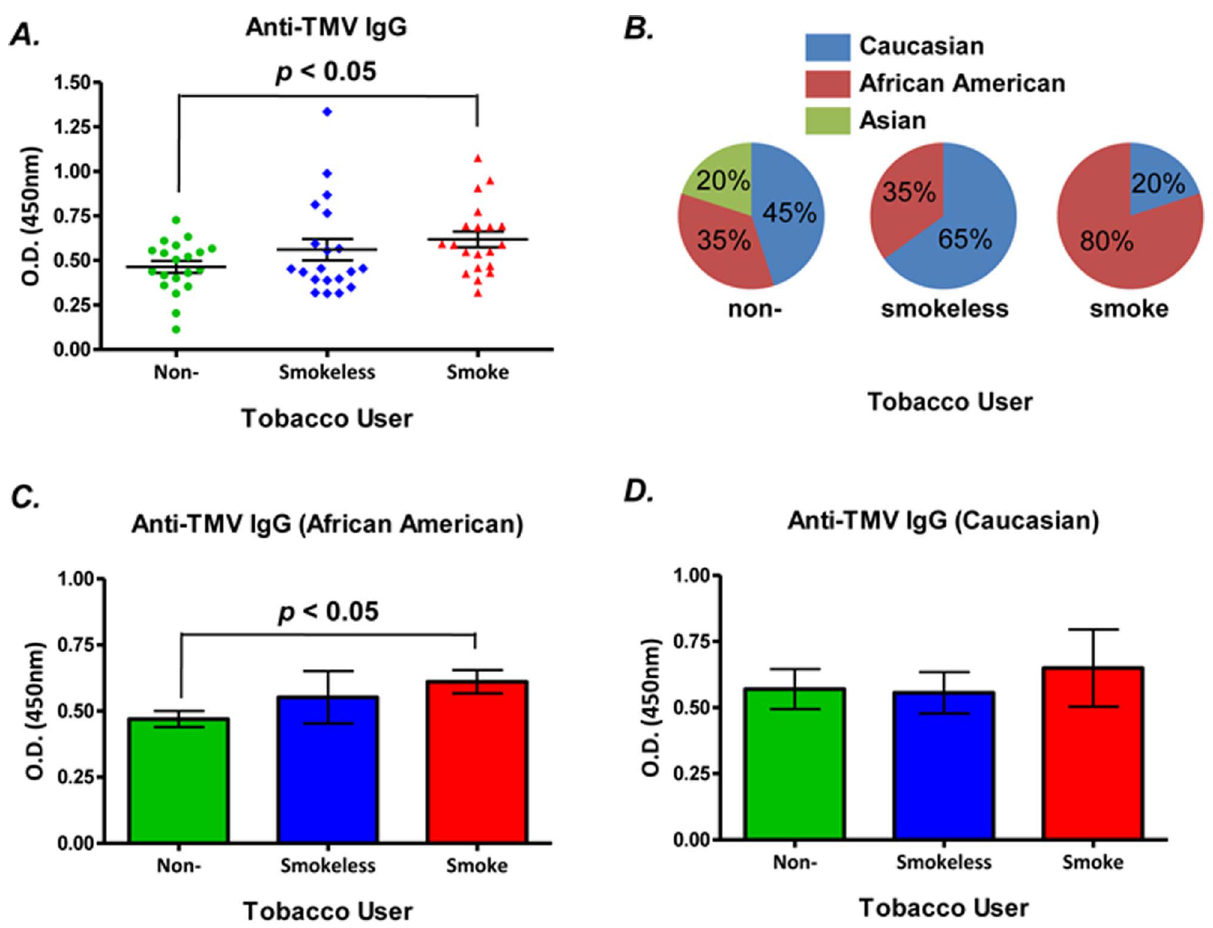
Figure 1. Effects of tobacco-smoke and smokeless-tobacco exposure on serum anti-Tobacco Mosaic Virus (TMV) IgG. Sera were obtained from groups of smoke tobacco users (smokers), smokeless tobacco users (tobacco chewers) and non-tobacco users (n = 20/group). Serum anti-TMV IgG levels were measured by a customized sandwich ELISA assay. The serum dilution factor was 1:100 and the data is expressed as O.D. value (mean 6 SE). All data are representative of two to three assays with similar results. (A) Serum anti-TMV IgG in whole study population; (B) Ethnic characteristics of the study population; (C) Serum anti-TMV IgG in African American study population; and (D) Serum anti-TMV IgG in Caucasian study population. p -value, Student’s t test, * p , 0.05. doi:10.1371/journal.pone.0060621.g001 0.03; p , 0.05, t test), but not in the Caucasian smokers ( Figure 1D: 0.65 6 0.15 vs 0.57 6 0.08; p = 0.05, t test). For the Caucasian ethnic group, the serum level of anti-TMV IgG1 from smokers was marginally higher than non-smokers ( Table S2 ). Table 1. Levels of Anti-TMV IgG Subclass in Human Serum.